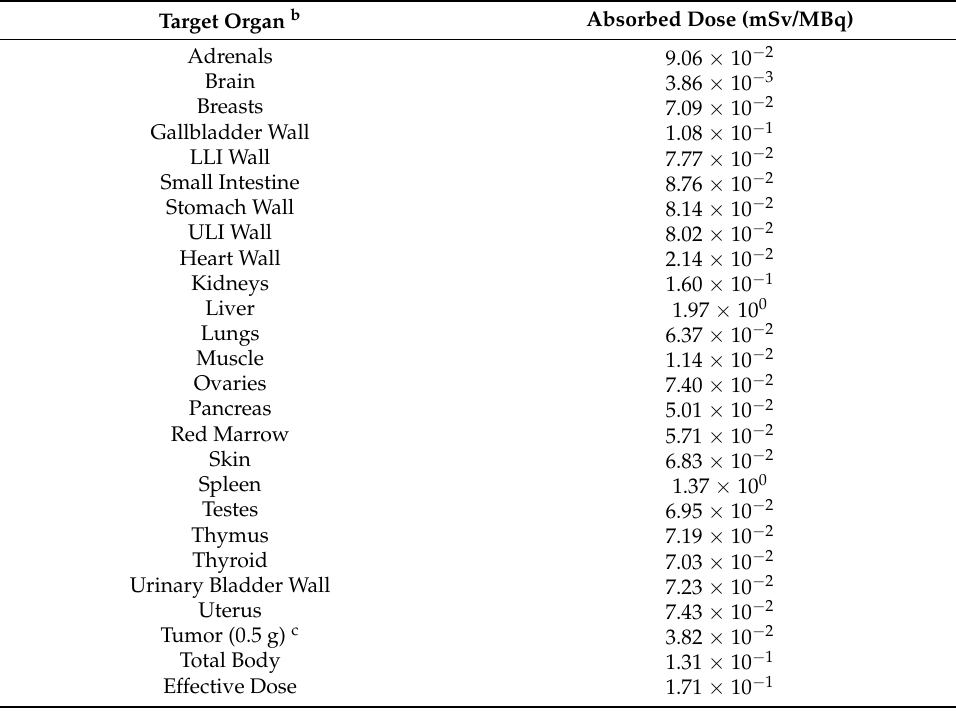
Table 3. Radiation dose estimates for intravenous injection of 177 Lu-DTPA-pAuNS in an adult human a